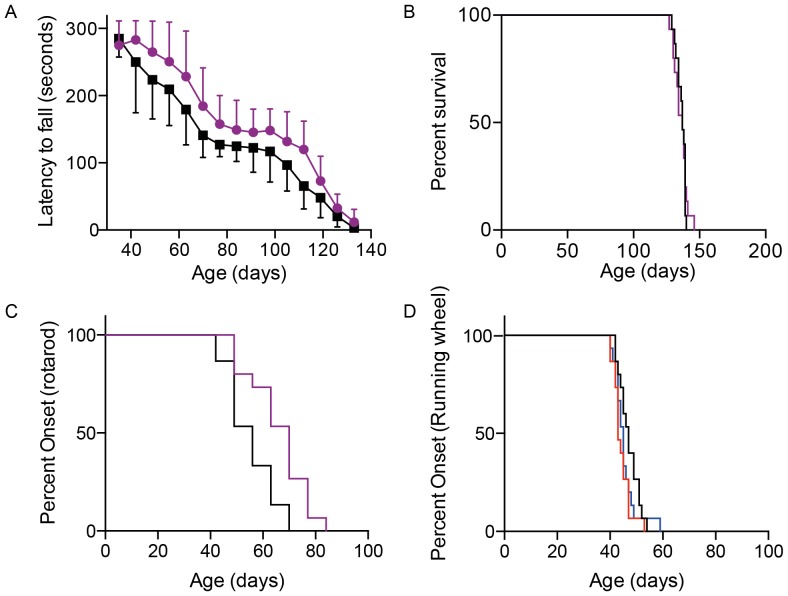
The effect of home cage running wheels on disease course in SOD1G93A mice.Graphs showing rotarod (A), survival (B), onset determined by a 20% reduction in rotarod performance (C), and onset determined by a 20% decrease in running wheel activity (D) in littermate SOD1G93A mice either with or without access to a home cage running wheel. In A–C mice with access to running wheels are shown in purple. In D onset determined by a 20% decline in the distance run is shown in red, time spent running is shown in blue and average speed is shown in black.